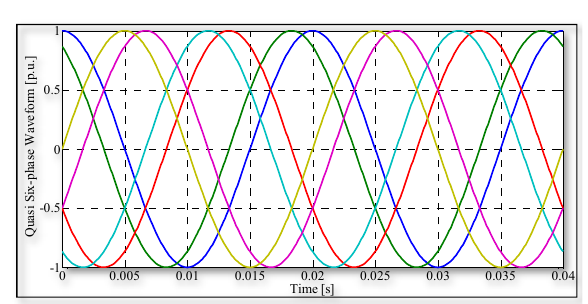
Figure 3. Asymmetrical or quasi six-phase output.